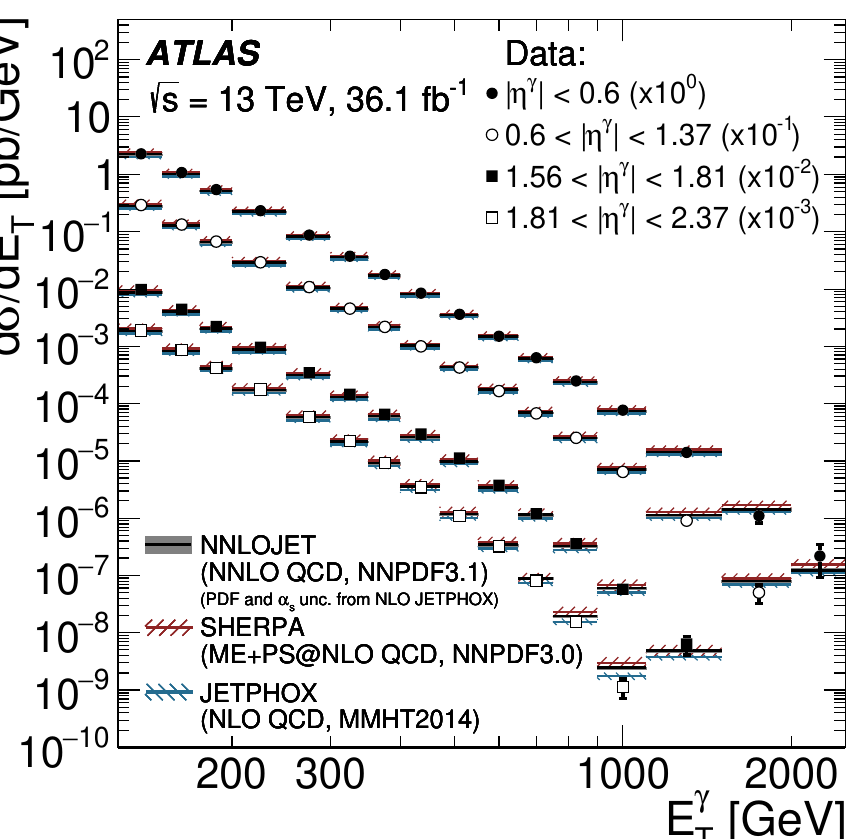
Figure 6 . The measured di(cid:11)erential cross section for isolated-photon production as a function of E (cid:13) in j (cid:17) (cid:13) j < 0 : 6 (black dots), 0 : 6 < j (cid:17) (cid:13) j < 1 : 37 (open circles), 1 : 56 < j (cid:17) (cid:13) j < 1 : 81 (black T squares) and 1 : 81 < j (cid:17) (cid:13) j < 2 : 37 (open squares). The NLO pQCD prediction from Jetphox , the ME+PS@NLO QCD prediction from Sherpa 2.2.2 and the NNLO QCD prediction from Nnlo- jet are also shown. The measurement and the predictions are normalised by the factors shown in parentheses to aid visibility. The error bars represent the data statistical uncertainties and system- atic uncertainties added in quadrature. For most of the points, the error bars are smaller than the marker size and, thus, not visible. The bands represent the theoretical uncertainty associated with the predictions; in the case of Nnlojet , the uncertainties due to the PDFs and (cid:11) s are estimated at NLO with Jetphox